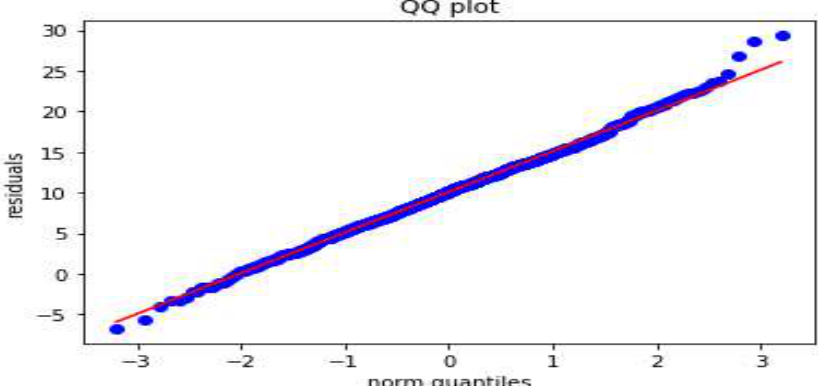
Figure 25. QQ plot shows data variability along a normal quantile distribution.